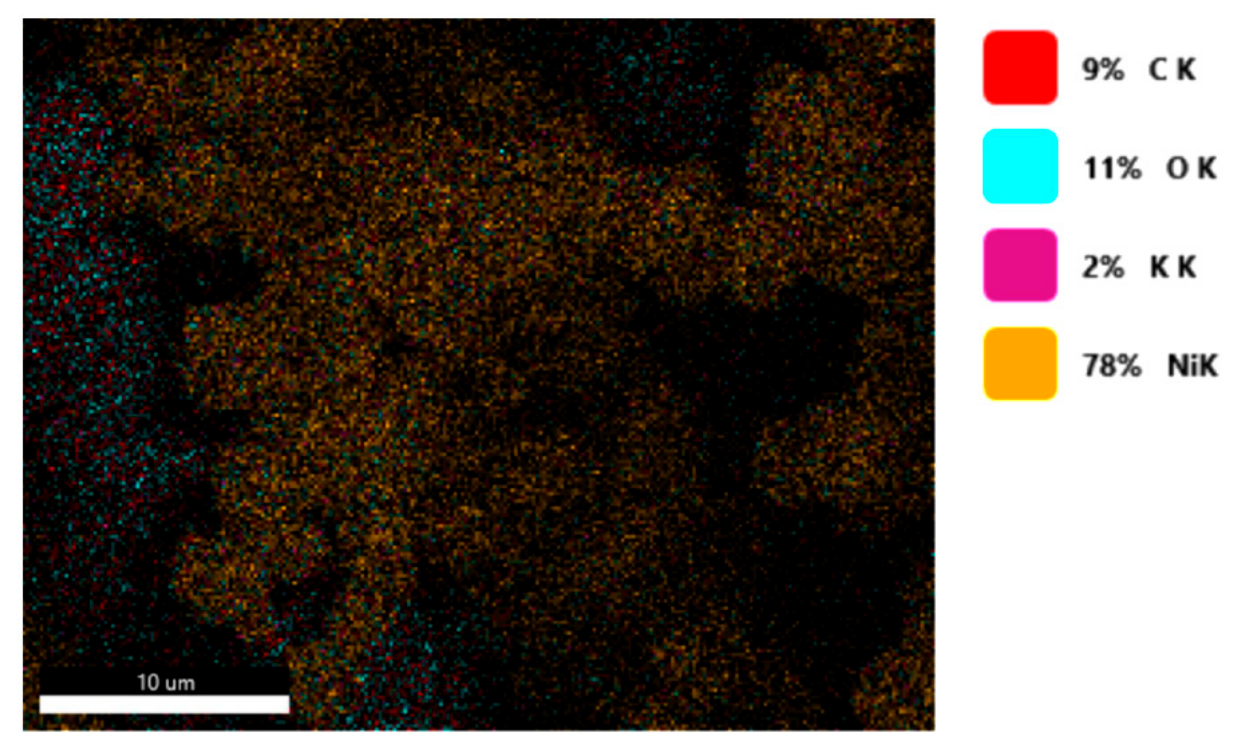
Figure 18. ESD spectra and elemental overlay for sample S3 treated in RF plasma O 2 , using RF 2 generator and power 100 W and Ni paste